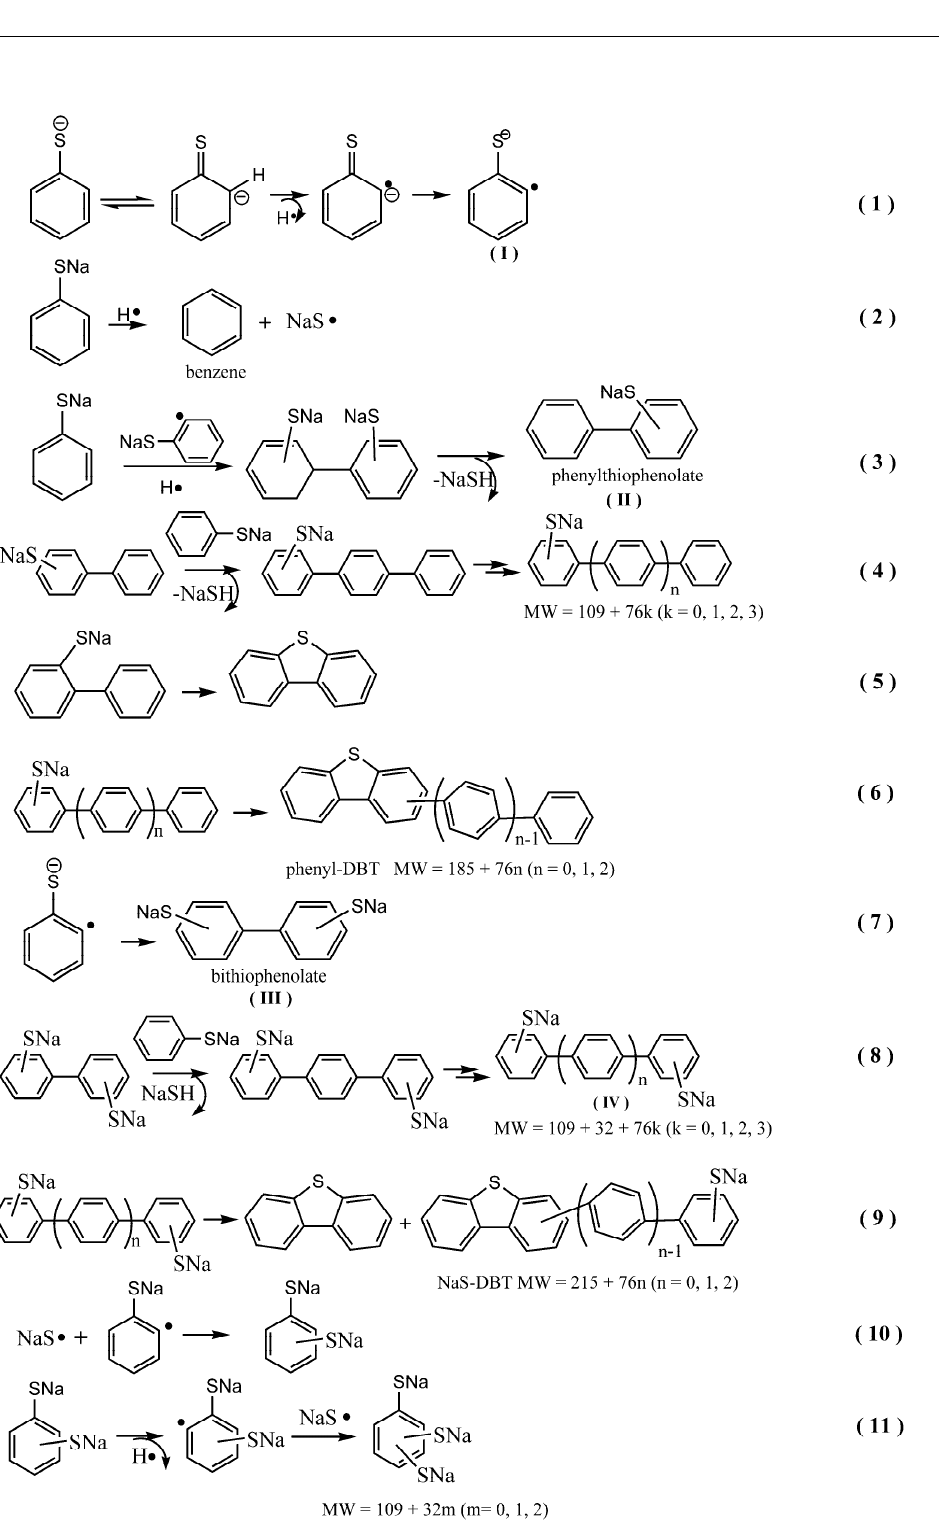
9 of 16 Figure 7. Q-TOF spectrum of sodium thiophenolate thermally treated on alcohol flame (APCI pos-